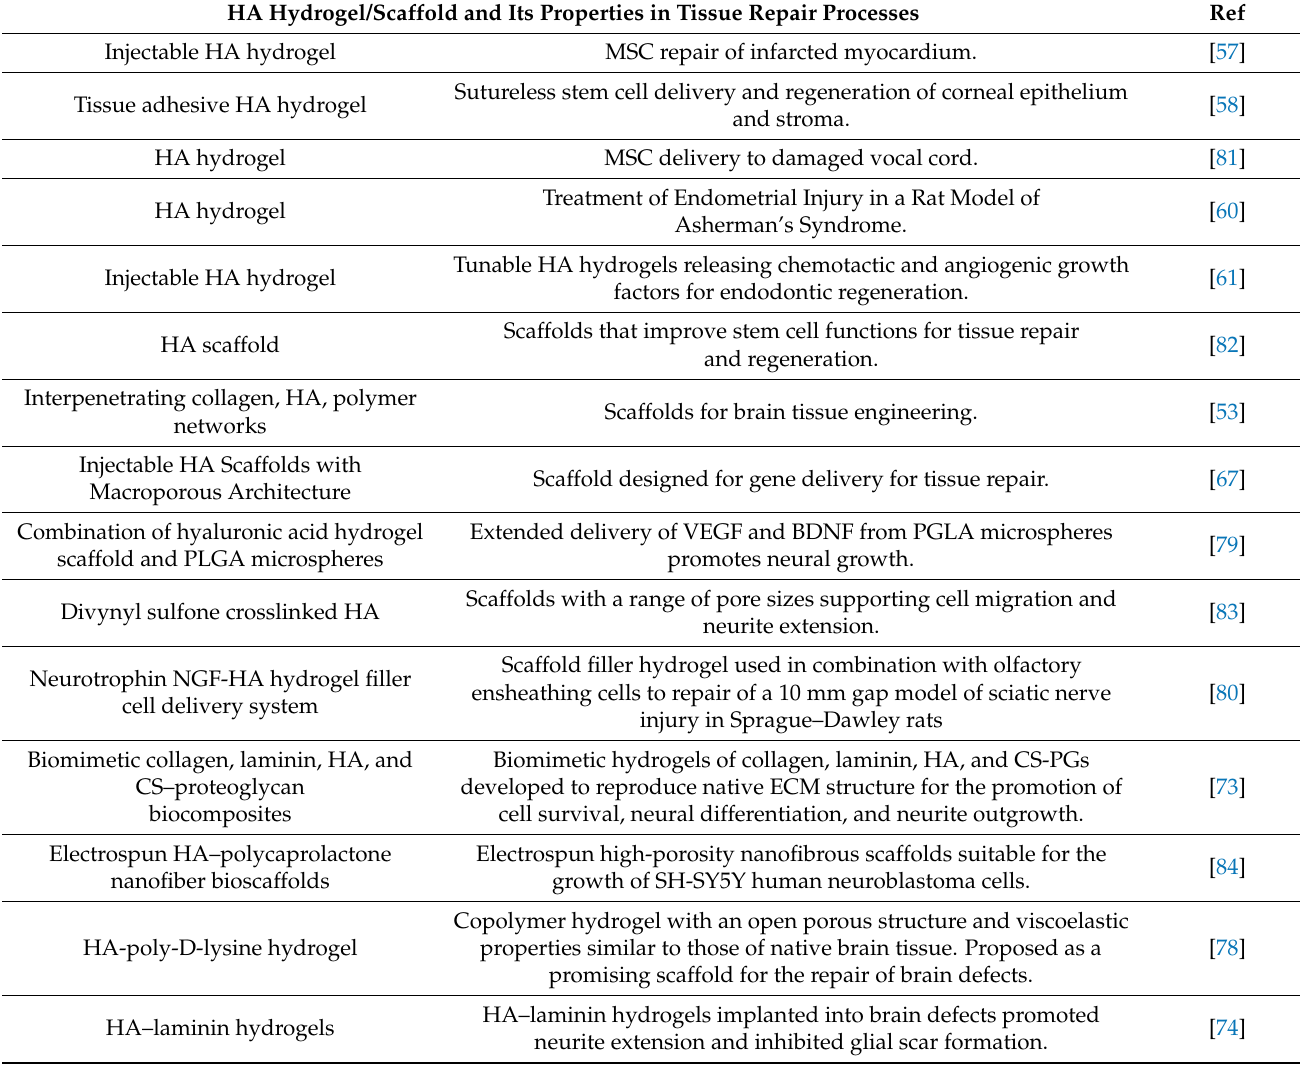
Table 1. The Versatility of HA in the Development of Hydrogels and Bioscaffolds for Tissue Repair. HA Hydrogel/Scaffold and Its Properties in Tissue Repair Processes Ref Injectable HA hydrogel MSC repair of infarcted myocardium. and stroma. MSC delivery to damaged vocal